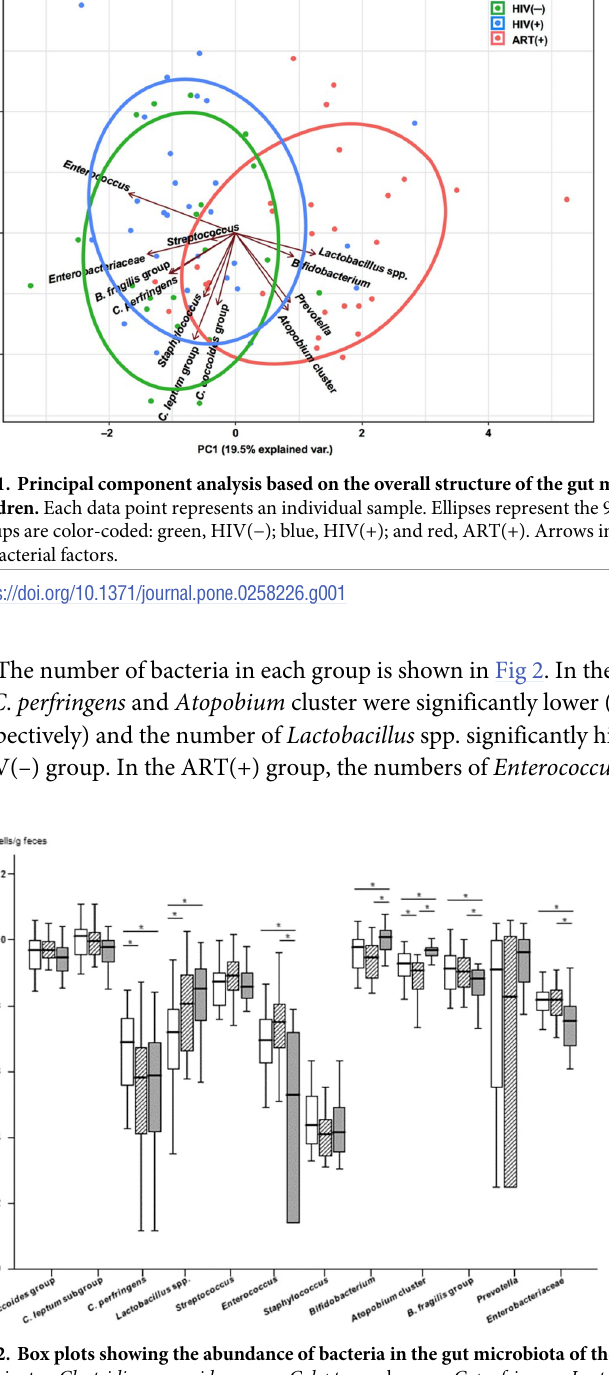
Fig 2. Box plots showing the abundance of bacteria in the gut microbiota of the three study groups. Phylum Firmicutes: Clostridium coccoides group, C . leptum subgroup, C . perfringens , Lactobacillus spp., Streptococcus , Enterococcus , and Staphylococcus ; phylum Actinobacteria: Bifidobacterium and Atopobium cluster; phylum Bacteroidetes: Bacteroides fragilis group and Prevotella ; and phylum Proteobacteria: Enterobacteriaceae . The lines and error bars correspond to the medians ± 95% confidence intervals. White box, HIV( − ) group; oblique line box, HIV(+) group; gray box, ART(+) group. � P < 0.05, Mann-Whitney U test. C . difficile and Pseudomonas were not included due to the low detection frequencies (3.4% to 20% in all three groups; C . difficile , median = 1.15 log 10 cells/g feces, and Pseudomonas , median = 1.45 log 10 cells/g feces, S2